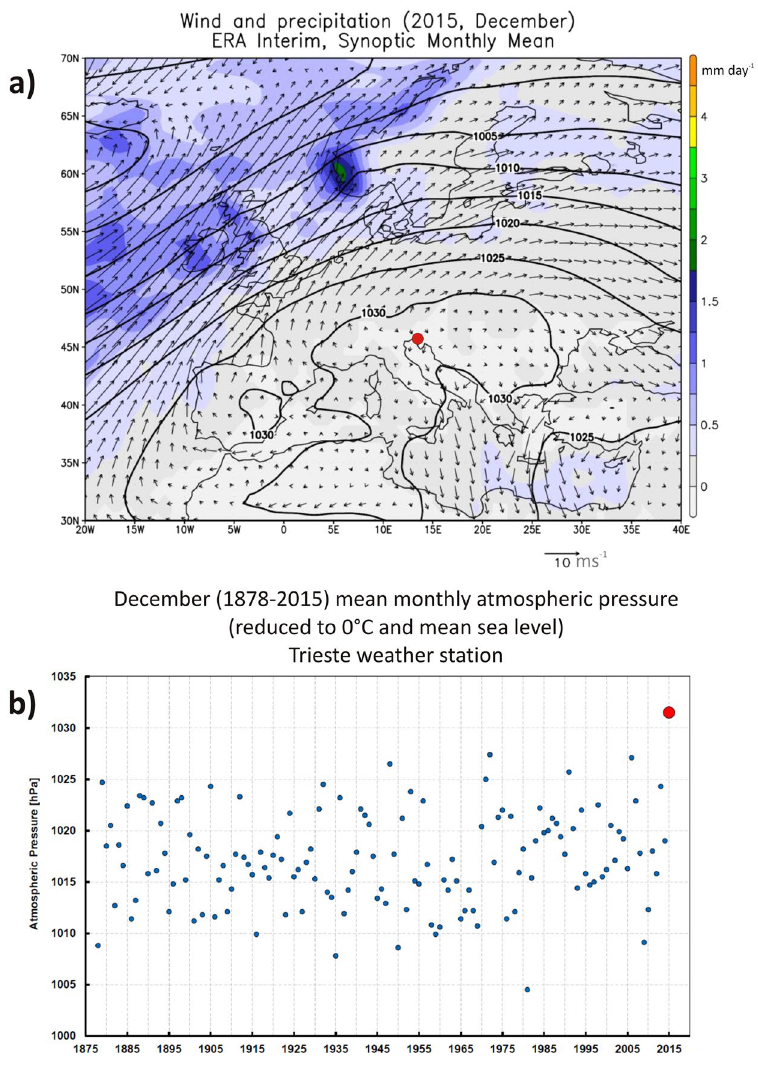
Figure 4. Top panel (a): December 2015 sea level pressure (hPa, contour lines), precipitation (mm/day, colors) and surface wind (m/s, arrows) from the ERA-Interim reanalysis (http://apps.ecmwf.int/datasets/). The map has been created with the software Grads (http://cola.gmu.edu/grads/). Bottom panel (b): time series of December sea level pressure (hPa) at Trieste (red dot in panel a), located in the northeastern Adriatic coasts of